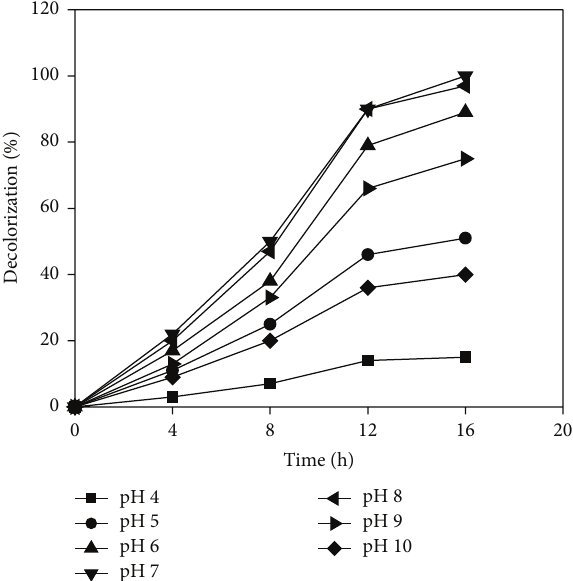
Figure 4: Effect of pH on decolorization of Reactive Violet 5.